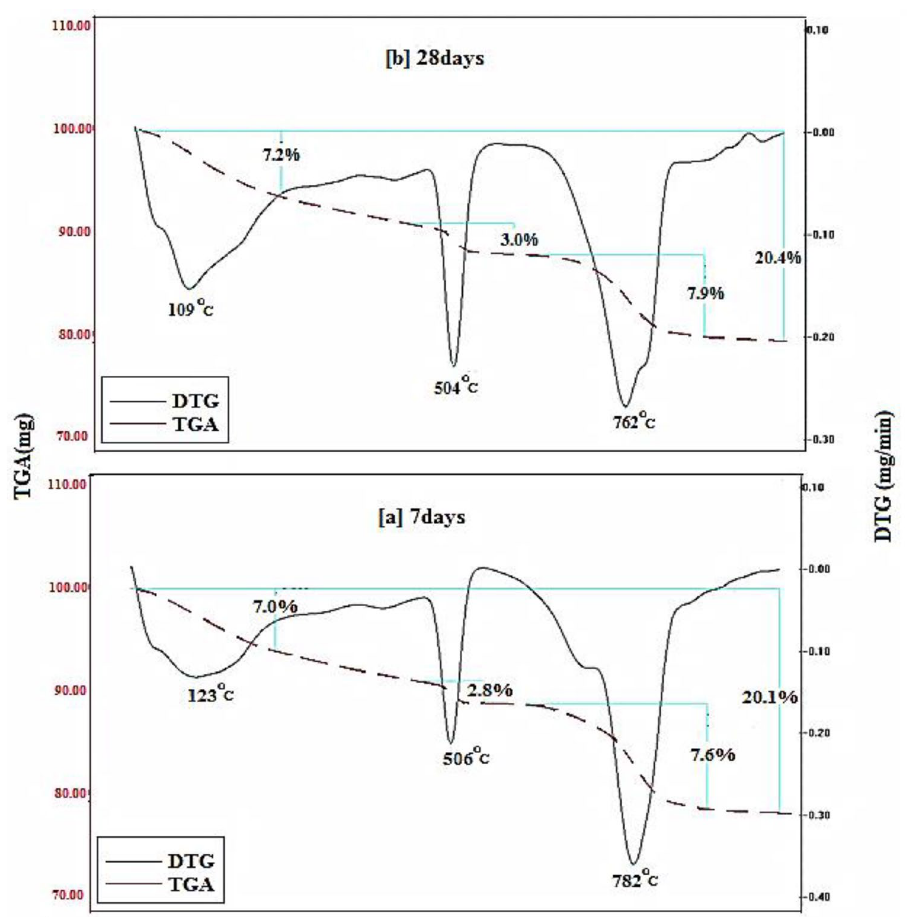
Figure 18. TGA/DTG thermograms of hardened specimens made from mix CNMFs0.5 at ( a ) 7 days and ( b ) 28 days